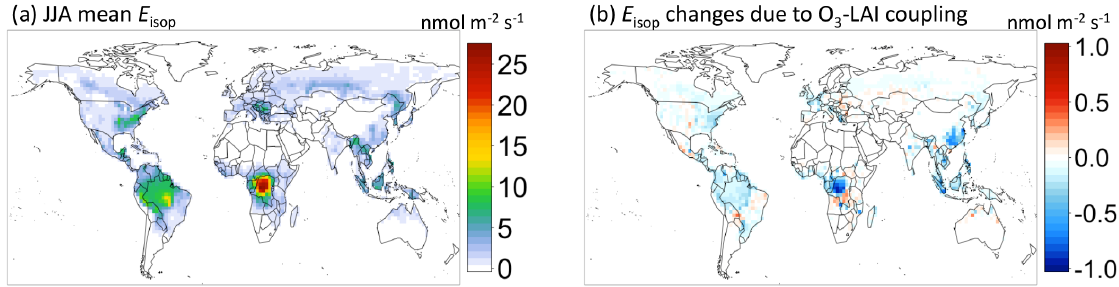
Figure 5. (a) Isoprene emission rate ( E isop ) in summer (JJA mean) from the Affected_LAI case, and (b) differences in isoprene emission rate between the Affected_LAI and Intact_LAI case (i.e., Affected_LAI – Intact_LAI).